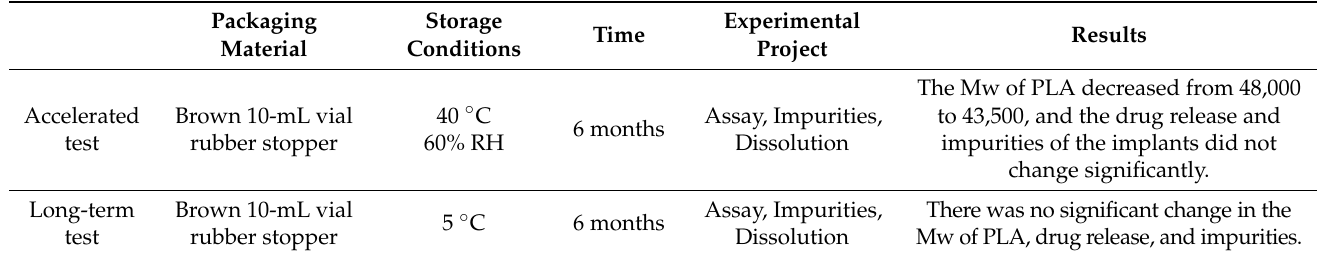
Table 6. Investigation data of implant